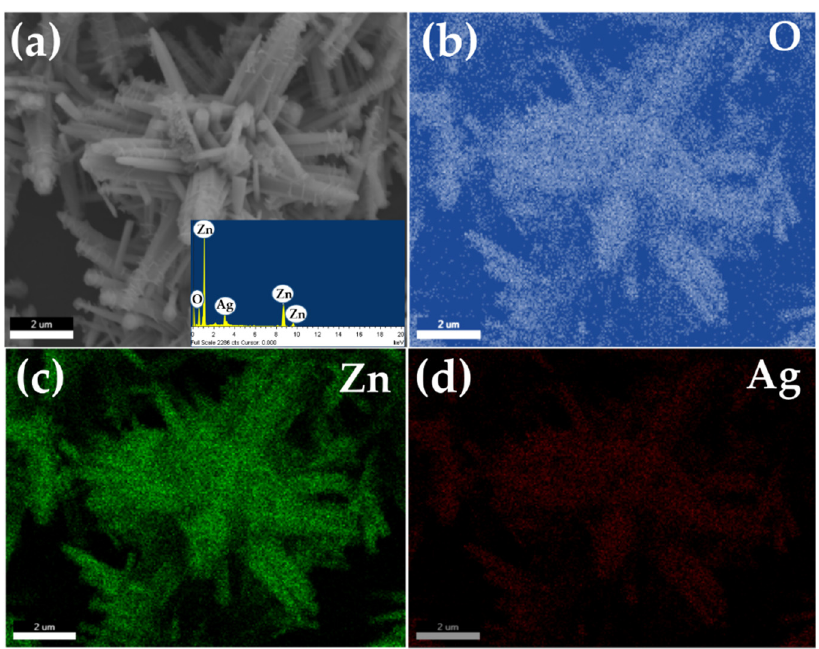
Figure 3. Typical ( a ) SEM image (inset: EDS spectrum) ( b – d ) O, Zn and Ag elemental mapping of synthesized Ag-doped ZnO nanoflowers.